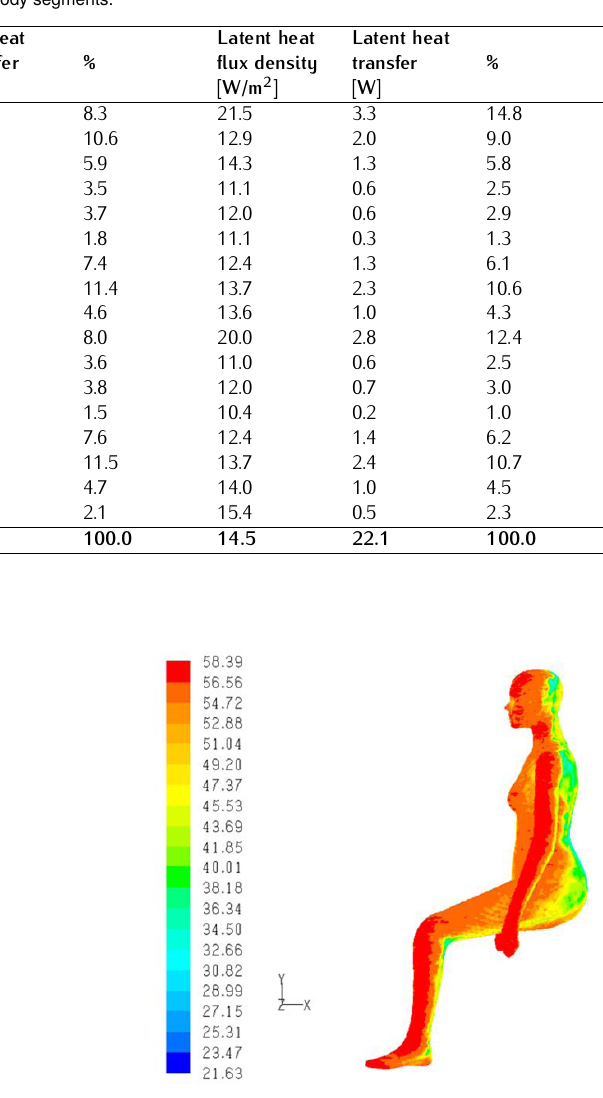
Table 1. Predicted heat loss and heat flux density from the body segments.